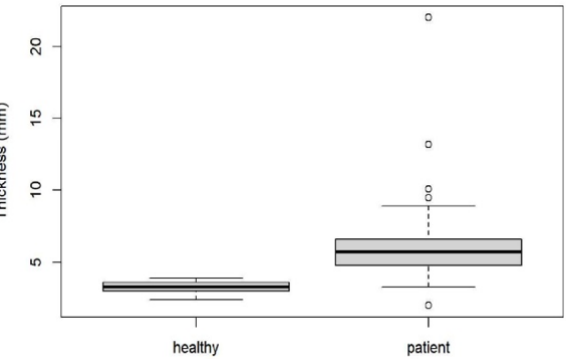
Figure 4. Box blot diagram showing plantar fascial thickness in healthy volunteers compared to patients with plantar fasciitis.